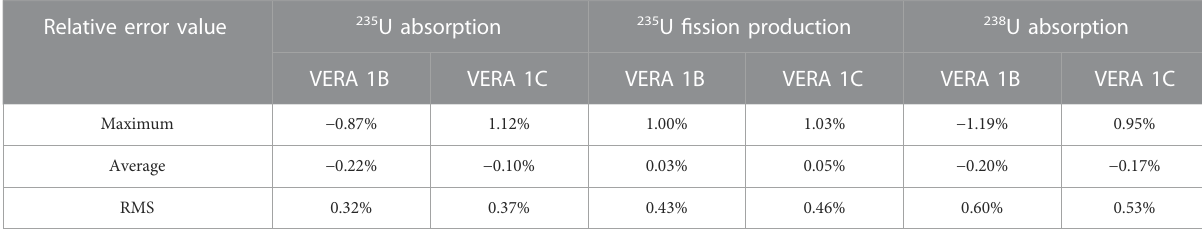
TABLE 7 Calculation results of the resonance cross section for VERA 1B and 1C cases.